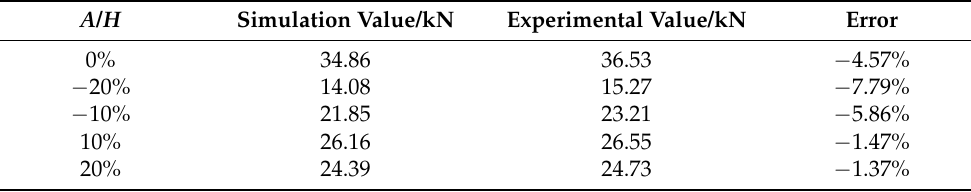
Table 4. Experimental and simulation results of fiber waviness